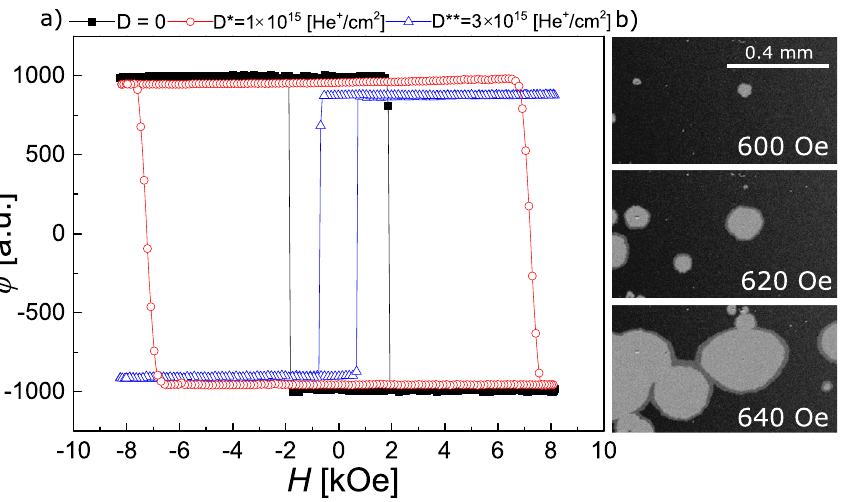
Figure 2. ( a ) Hysteresis loops of the reference areas in the as-deposited state (black squares), after IB with D* = 1 × 10 15 He + /cm 2 (red dots) and D** = 3 × 10 15 He + /cm 2 (blue triangles). ( b ) Representative images of the domain structure of the reference area subject to IB with D**